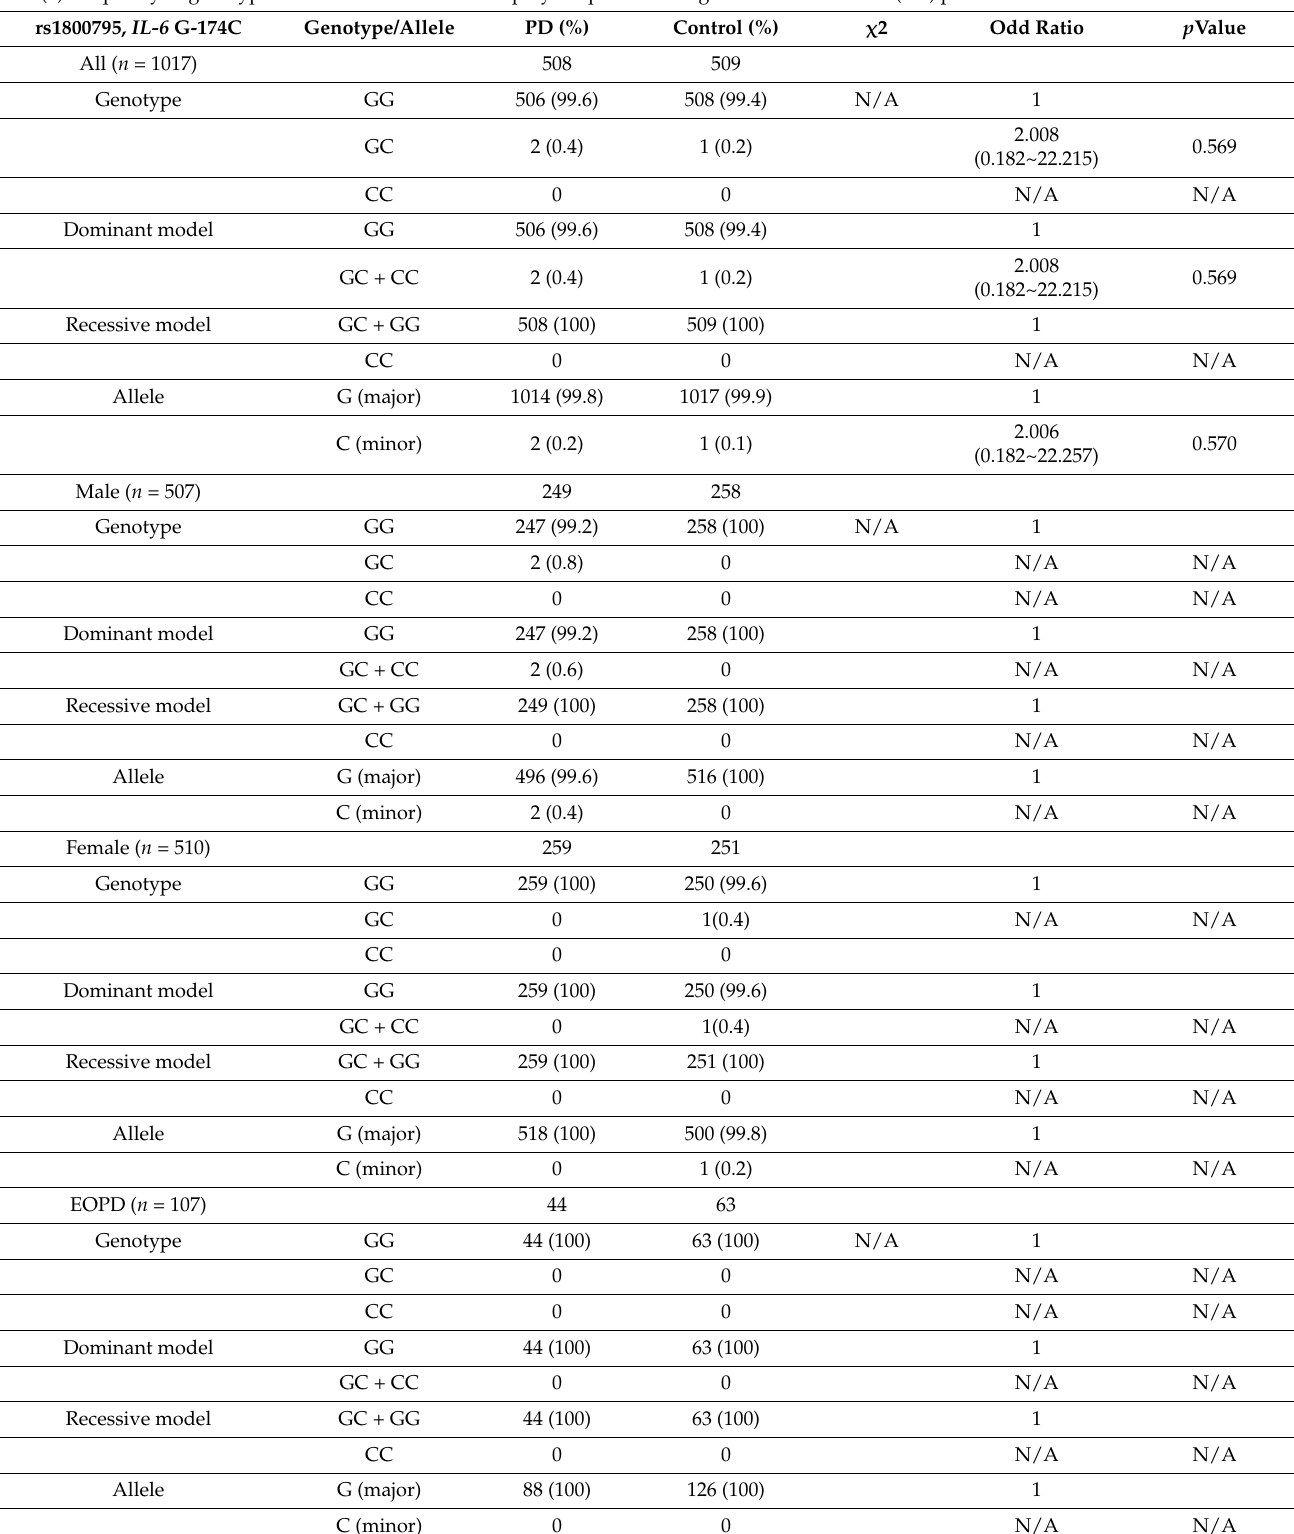
Table 2. Frequency of genotype and allele of IL6 rs1800795 and IL-8 rs4073 polymorphism among Parkinson’s Disease (PD) patients and controls in